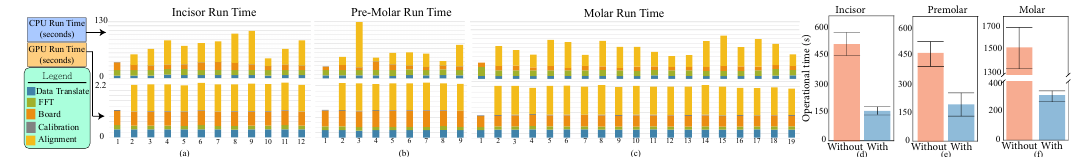
Figure 7. ( a – c ) The run time of each stage at various scans using a CPU (the top) and a GPU (the bottom) for the incisor, premolar, and molar teeth and ( d – f ) the statistics of our user study in the time of operation in the unit of seconds with/without using the visualization